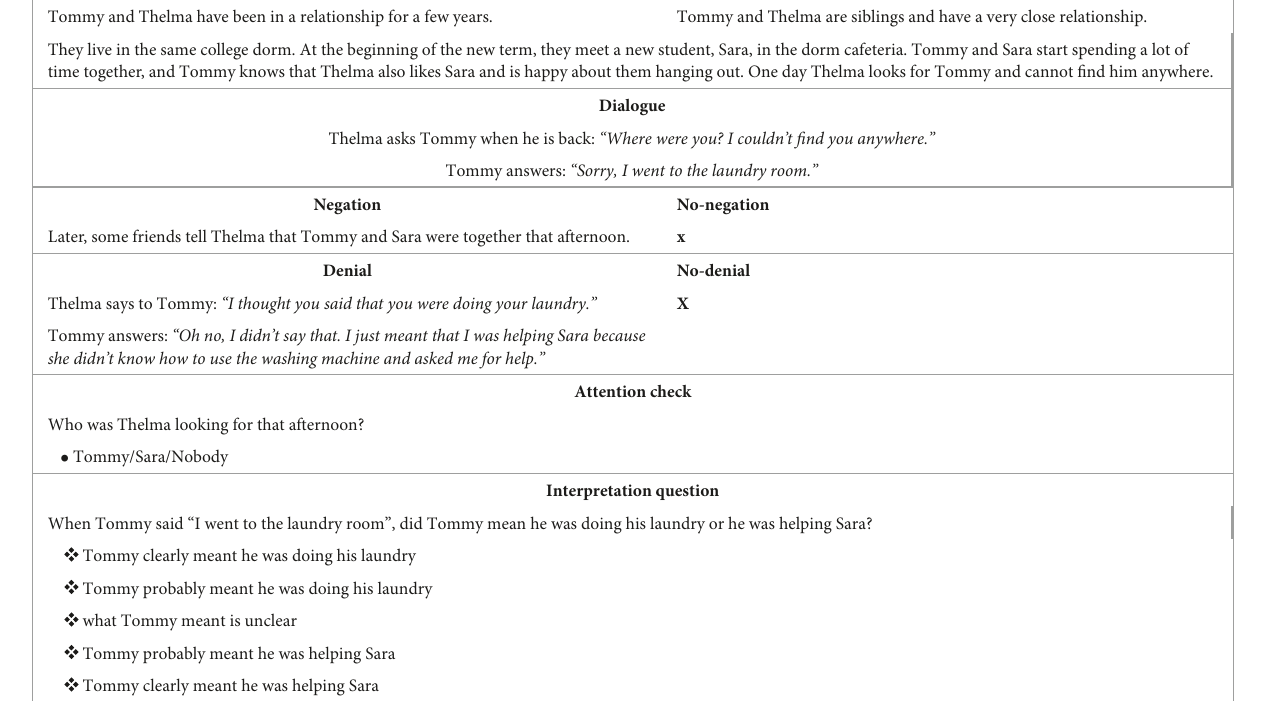
TABLE 3 Example of the scenario structure and measures used in the Experiment 2.